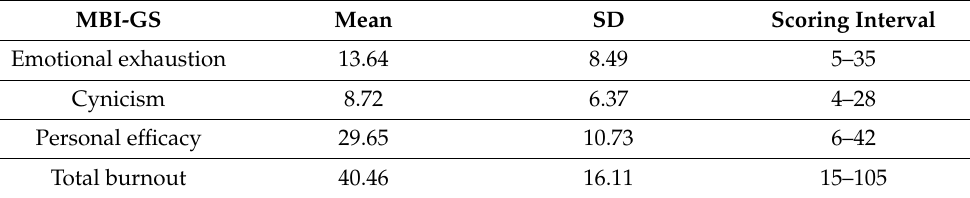
Table 1. Descriptive data of the dimensions measured by the MBI-GS.